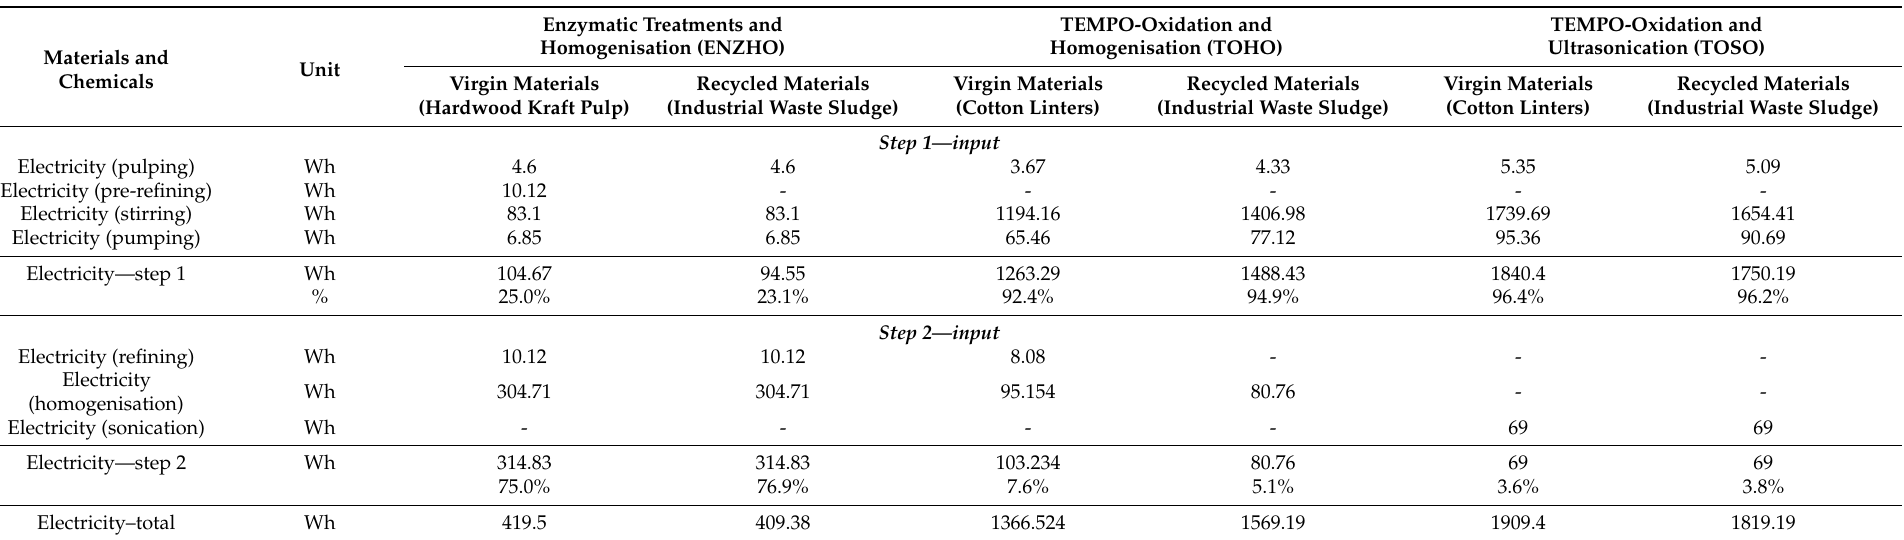
Table 3. Electrical energy consumption for the six CNFs produced at the lab scale; amounts are given per